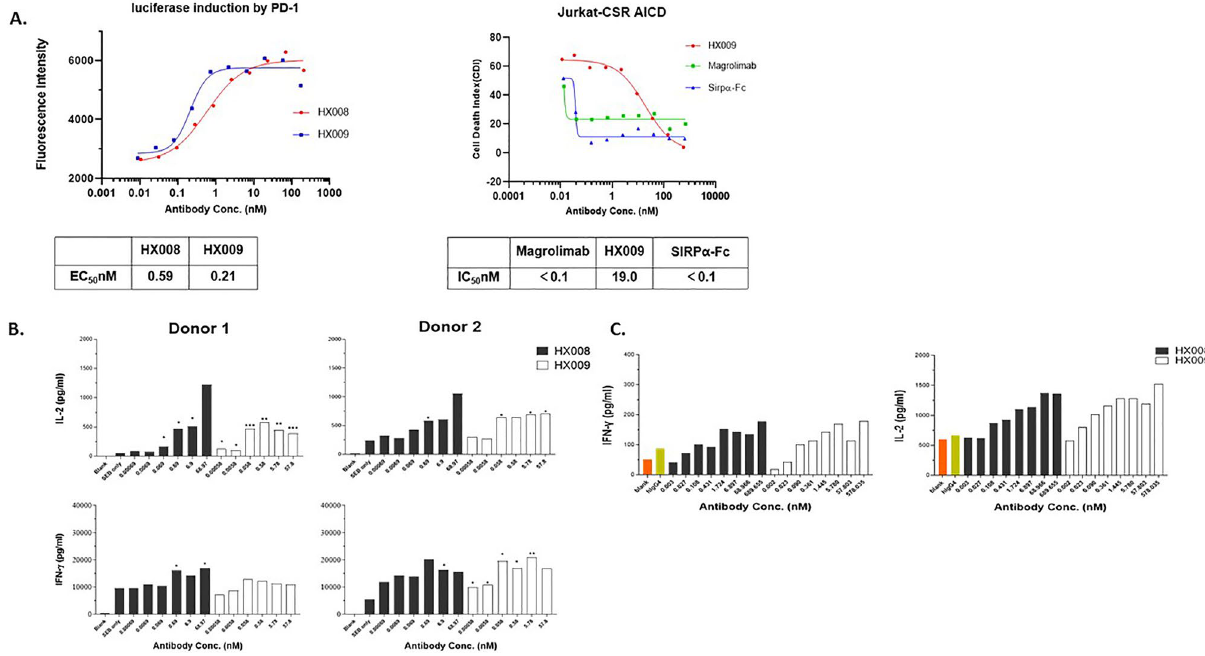
Figure 2. In vitro biological function characterizations of HX009. ( A ) Reporter assays for both target engagement. Left panel: Different concentration of HX009 and HX008 activated luciferase reporter expression in reporter cell lines by down-regulating PD1 /PD-L1 interaction, and EC 50 was determined according to four-parameter equation fitting curves 36 ; Right panel: CD47-hFc induced activation induced cell-death (AICD) in Jurkat-CSR reporter cells, where reporter cells were incubated with different concentrations of HX009, Magrolimab and hSIRPα-Fc to block CD47-SIRPα interaction to prevent reporter cells from AICD; IC 50 was calculated per the four-parameter equation fitting curves. Data were shown as average signal, n = 2. ( B ) T cell from two different donors were SEB stimulated, followed by reactivation by HX008 and HX009 after. IL-2 (upper panel) and IFN-γ (bottom panel) secretion were measured via an ELISA method. SEB only treatment was also measured for basal cytokine level. Data were shown as average signal, n = 2. p -values: ***:0–0.001, **: 0.001–0.01, *: 0.01–0.05 compared to the SEB-only treatment. ( C ) Activation of lymphocytes by HX009 treatment in mixed lymphocyte reaction (MLR) assay. IL-2 (left panel) and IFN-γ (right panel) secretion were measured via an ELISA method. Blanks and IgG4 isotype control treatment were also measured for basal cytokine level. Data were shown as average signal, n =